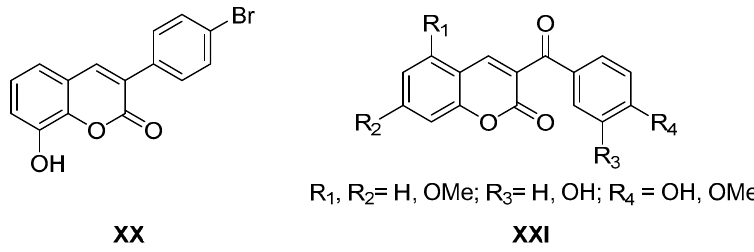
Figure 5. Structures of coumarin derivatives as adenosine ligands.